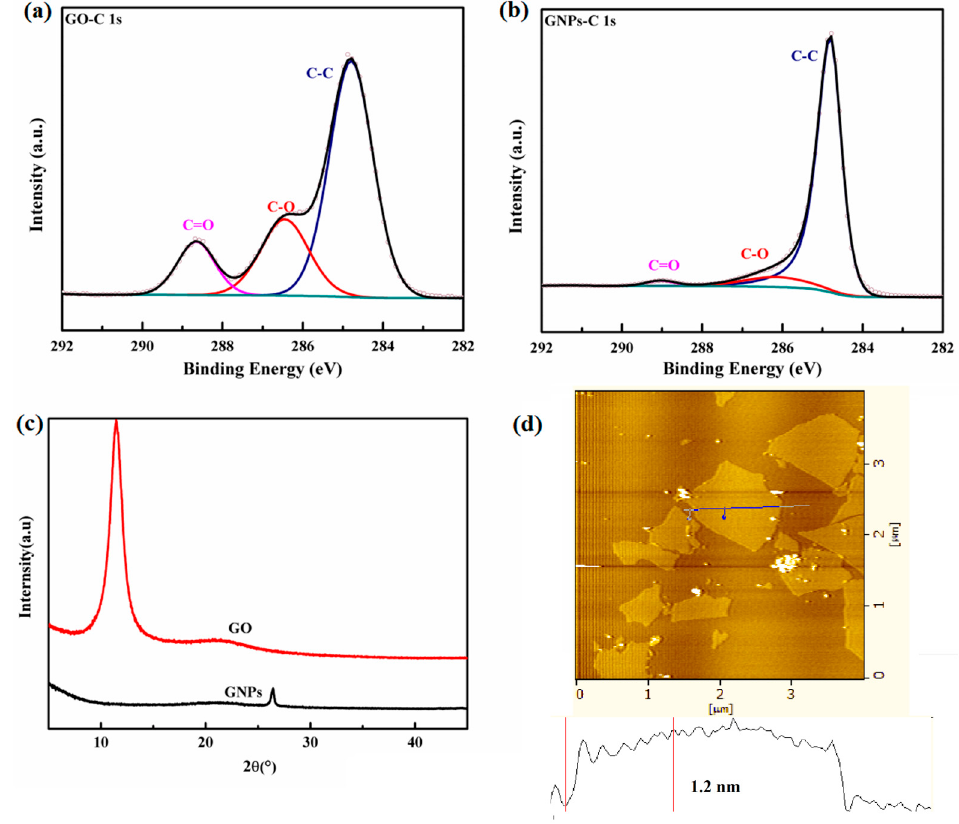
Figure 2. ( a ) XPS spectra of GO, ( b ) XPS spectra of GNPs, ( c ) FT-IR spectra of GO and GNPs, and ( d ) AFM image of GO with the height profile.